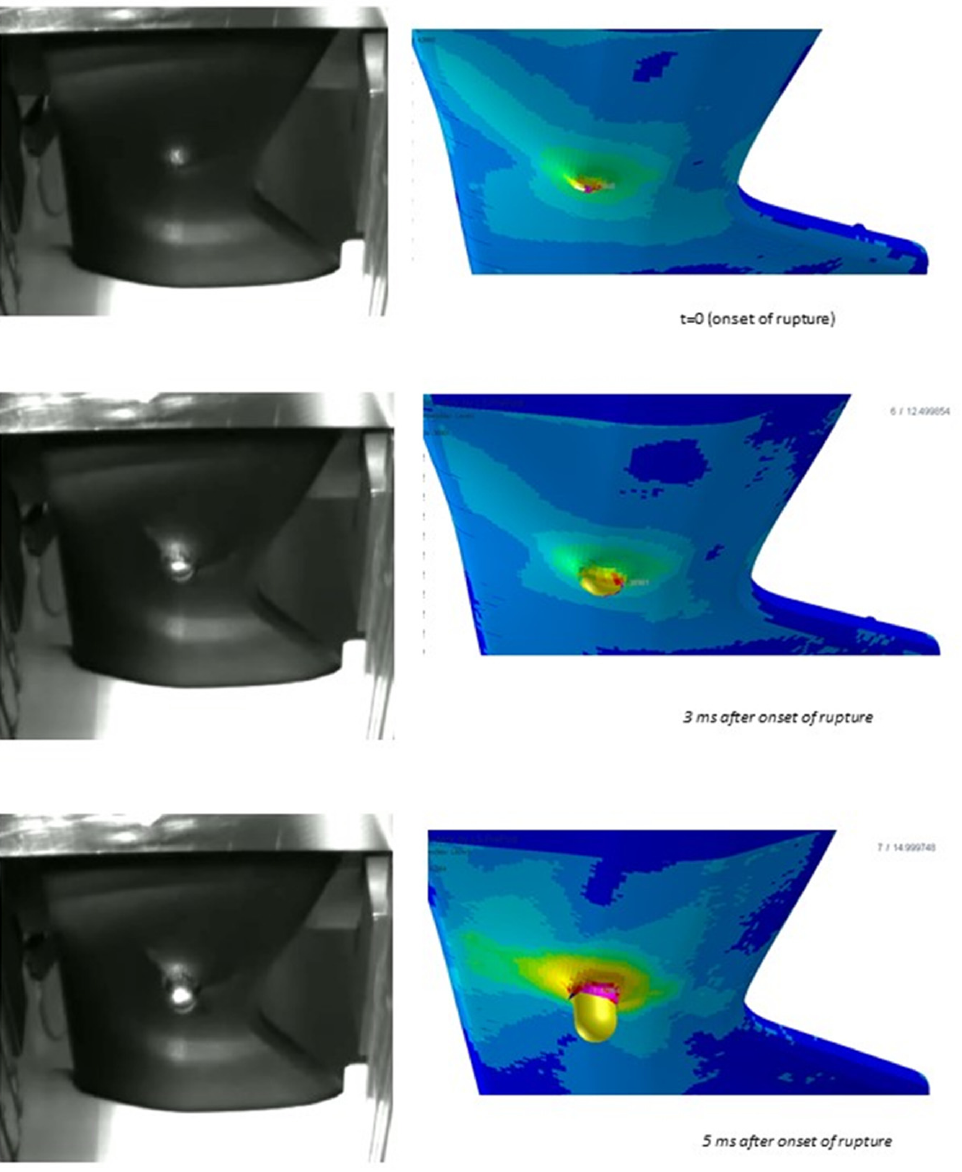
Figure 8. Comparison of fracture modes predicted by simulations ( right ) and observed experimen- tally ( left ) at different time instants during the impact sequence. Images refer to the 20 mm diameter impactor, impact speed of 3 m/s, and part thickness of 3.2 mm. Pictures from the experimental test provided by SMP GmbH., Bötzingen, Germany.